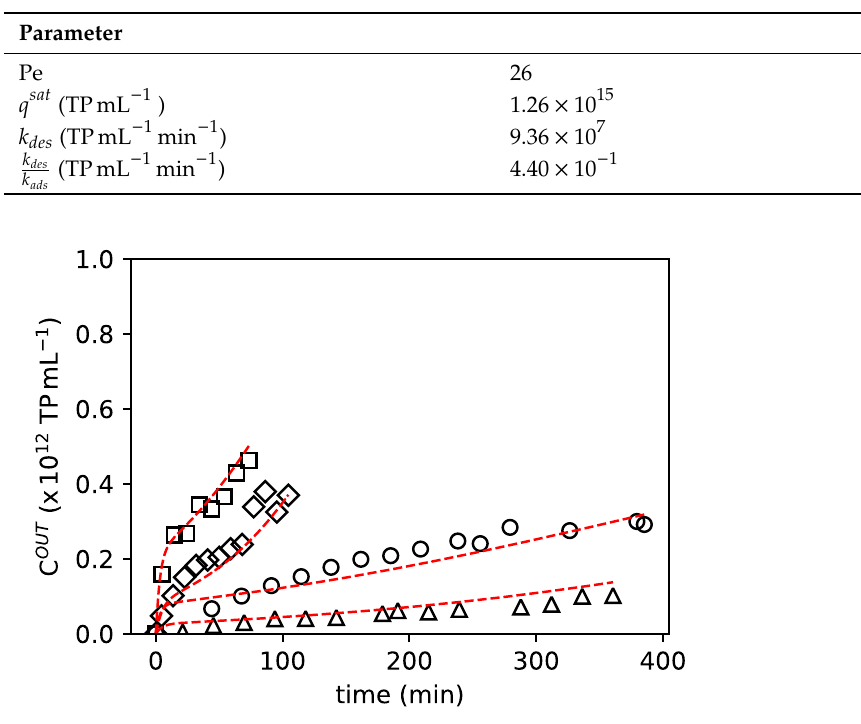
Figure 3. Fitting of breakthrough experiments with low-level of feed concentration: ○ : c FEED = − 1 6.40 × 10 11 TPmL and Q FEED = 0.51 mLmin − 1 0.33 mLmin . With high-level of feed concentration: ◇ : c FEED = 2.21 × 10 12 TPmL − 1 0.33 mLmin , □ : c FEED = 1.90 × 10 12 TPmL